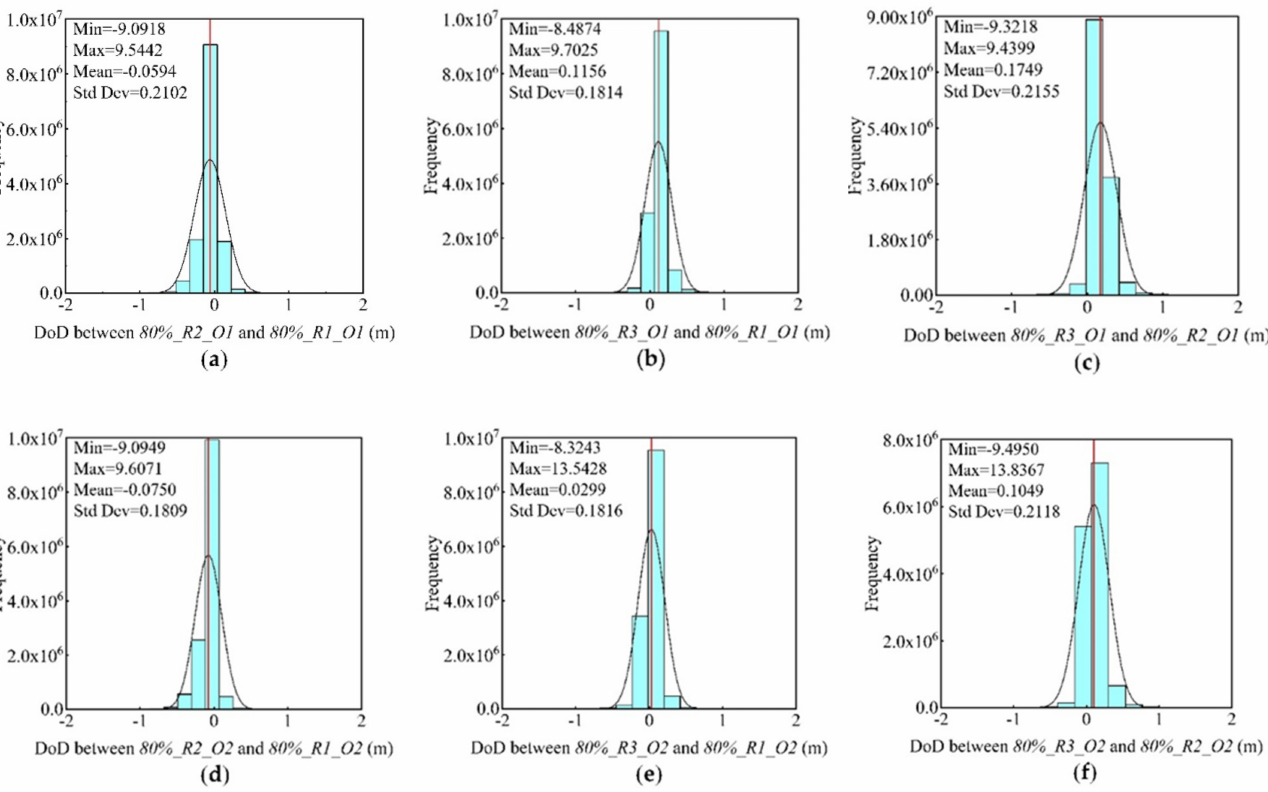
Figure 7. DoD results of different datasets under repeated observations. Histograms ( a – c ) represent the orthophoto datasets results. Histograms ( d – f ) represent the oblique imaging datasets.